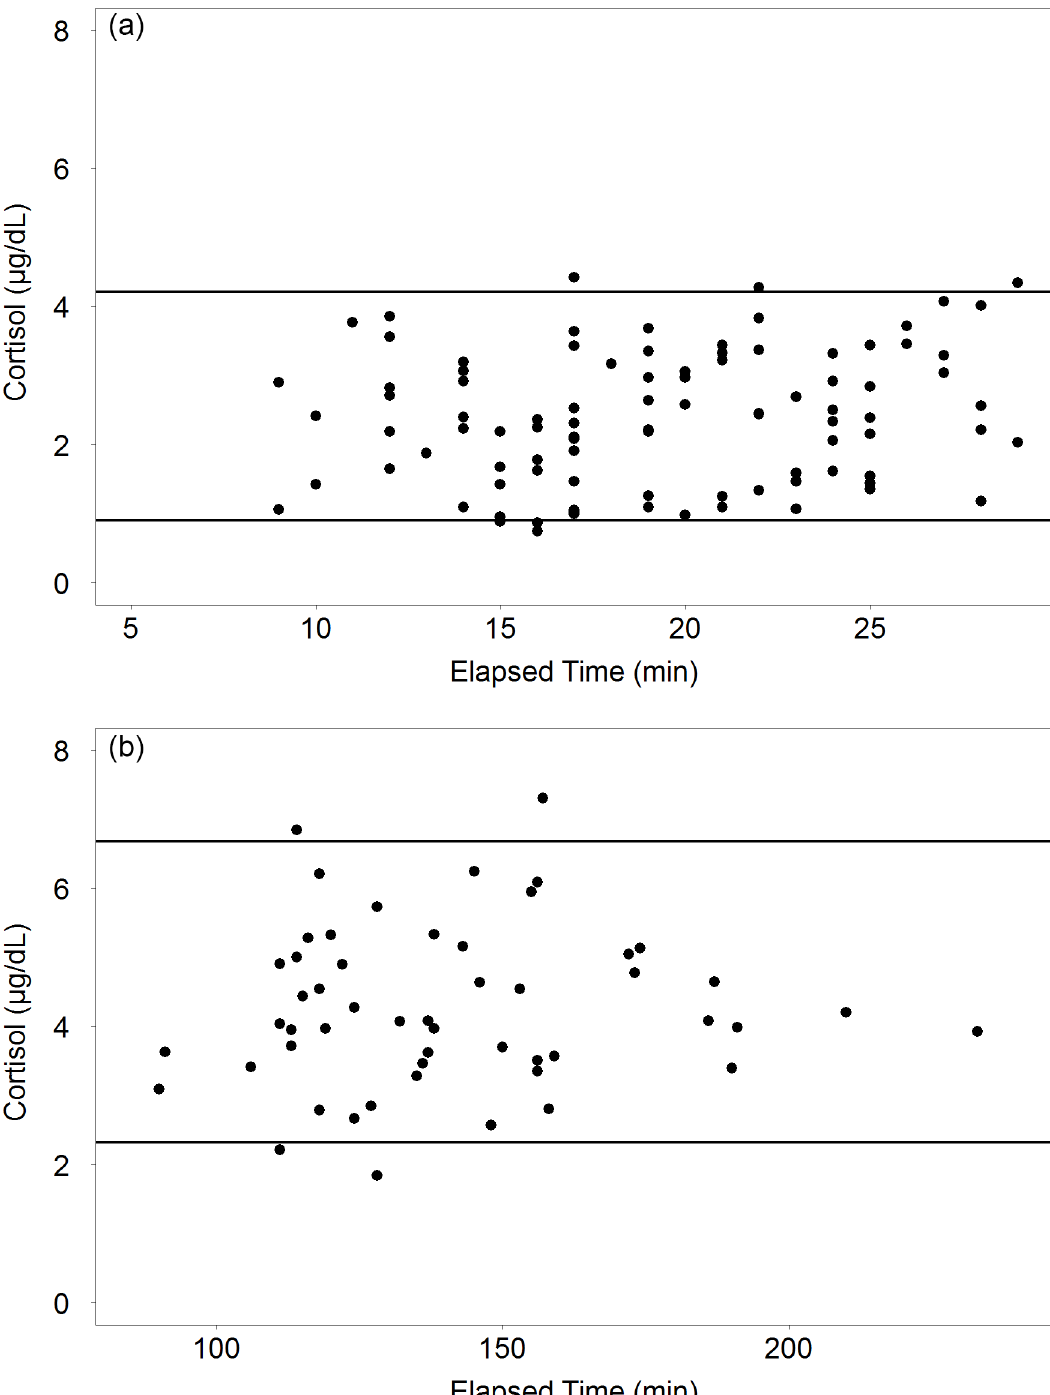
Fig 2. Cortisol Reference Intervals. (a) Pre-sampling ( < 30 minutes elapsed time) and (b) post-sampling 95 th percentile reference intervals for serum cortisol ( μ g/dL) versus elapsed sampling time (min). Points represent measured pre-sampling (N = 93) and post-sampling (N = 52) serum cortisol values for bottlenose dolphins sampled in Sarasota Bay, FL 2000 – 2012; solid lines represent upper and lower bounds for the 95 th percentile.